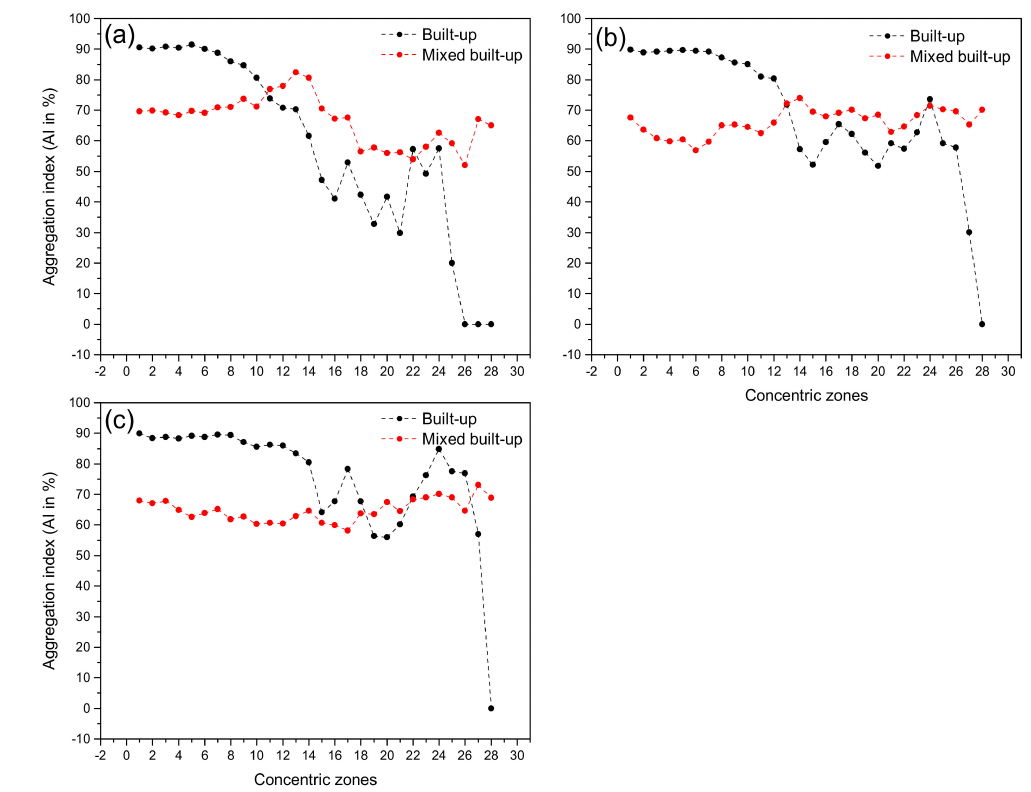
Figure 20. Pattern of AI in the sequential concentric zones of 1 km each around the river Hooghly within the KMA; the pattern of AI of built-up and mixed built-up for the concentric zones in ( a ) 1996, ( b ) 2006, and ( c )